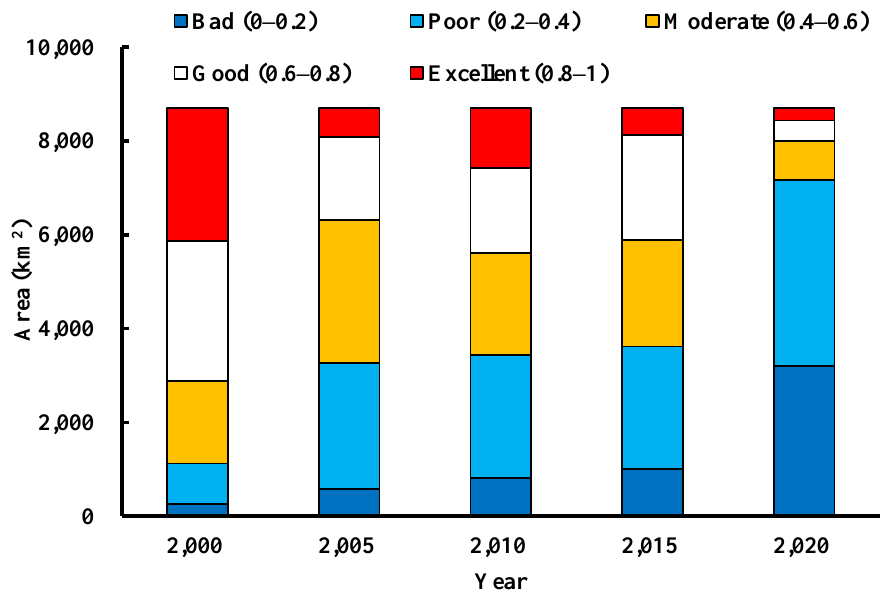
Figure 4. Spatial distribution of different RSEI quality levels in the Kuye River Basin in 2000, 2005, 2010, 2015, and 2020.